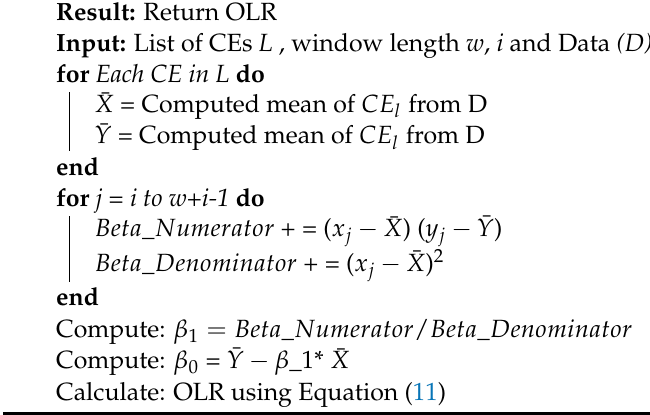
Algorithm 1: Online Linear Regression